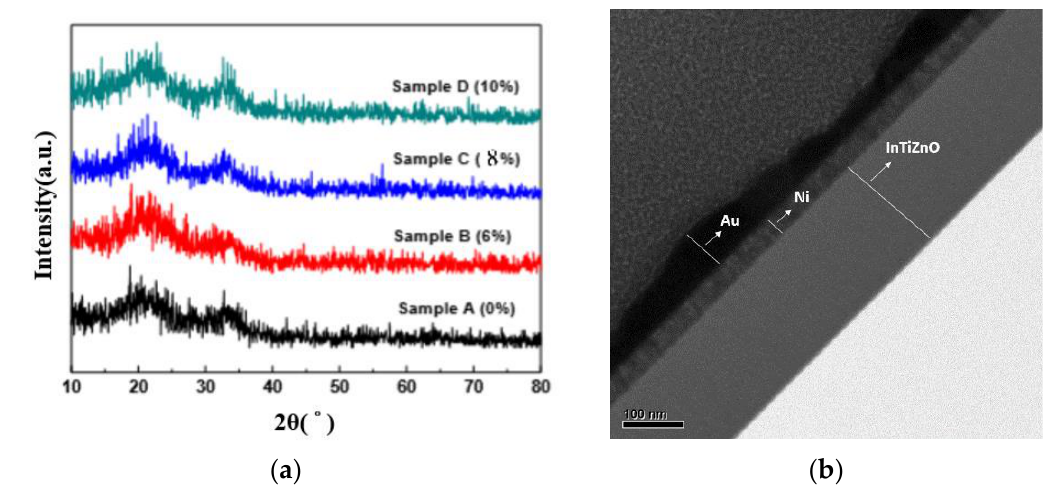
Figure 2. ( a ) XRD spectra of as-deposited InTiZnO thin film with various oxygen flow ratios ( b ) cross-section TEM image of InTiZnO film.